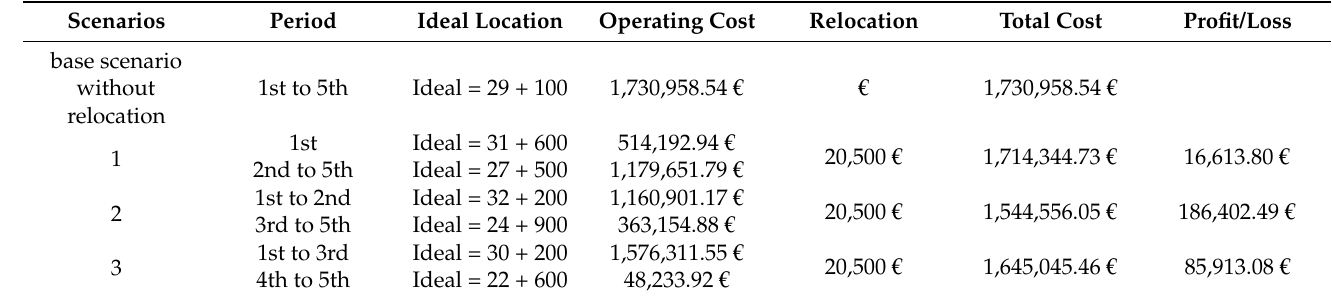
Table 10. Operating costs results of the fourth project.